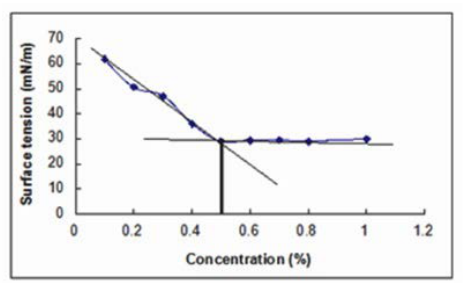
Fig. 3. Critical micelle concentration and minimum surface tension analysis of biosurfactant by C. tropicalis RA1.